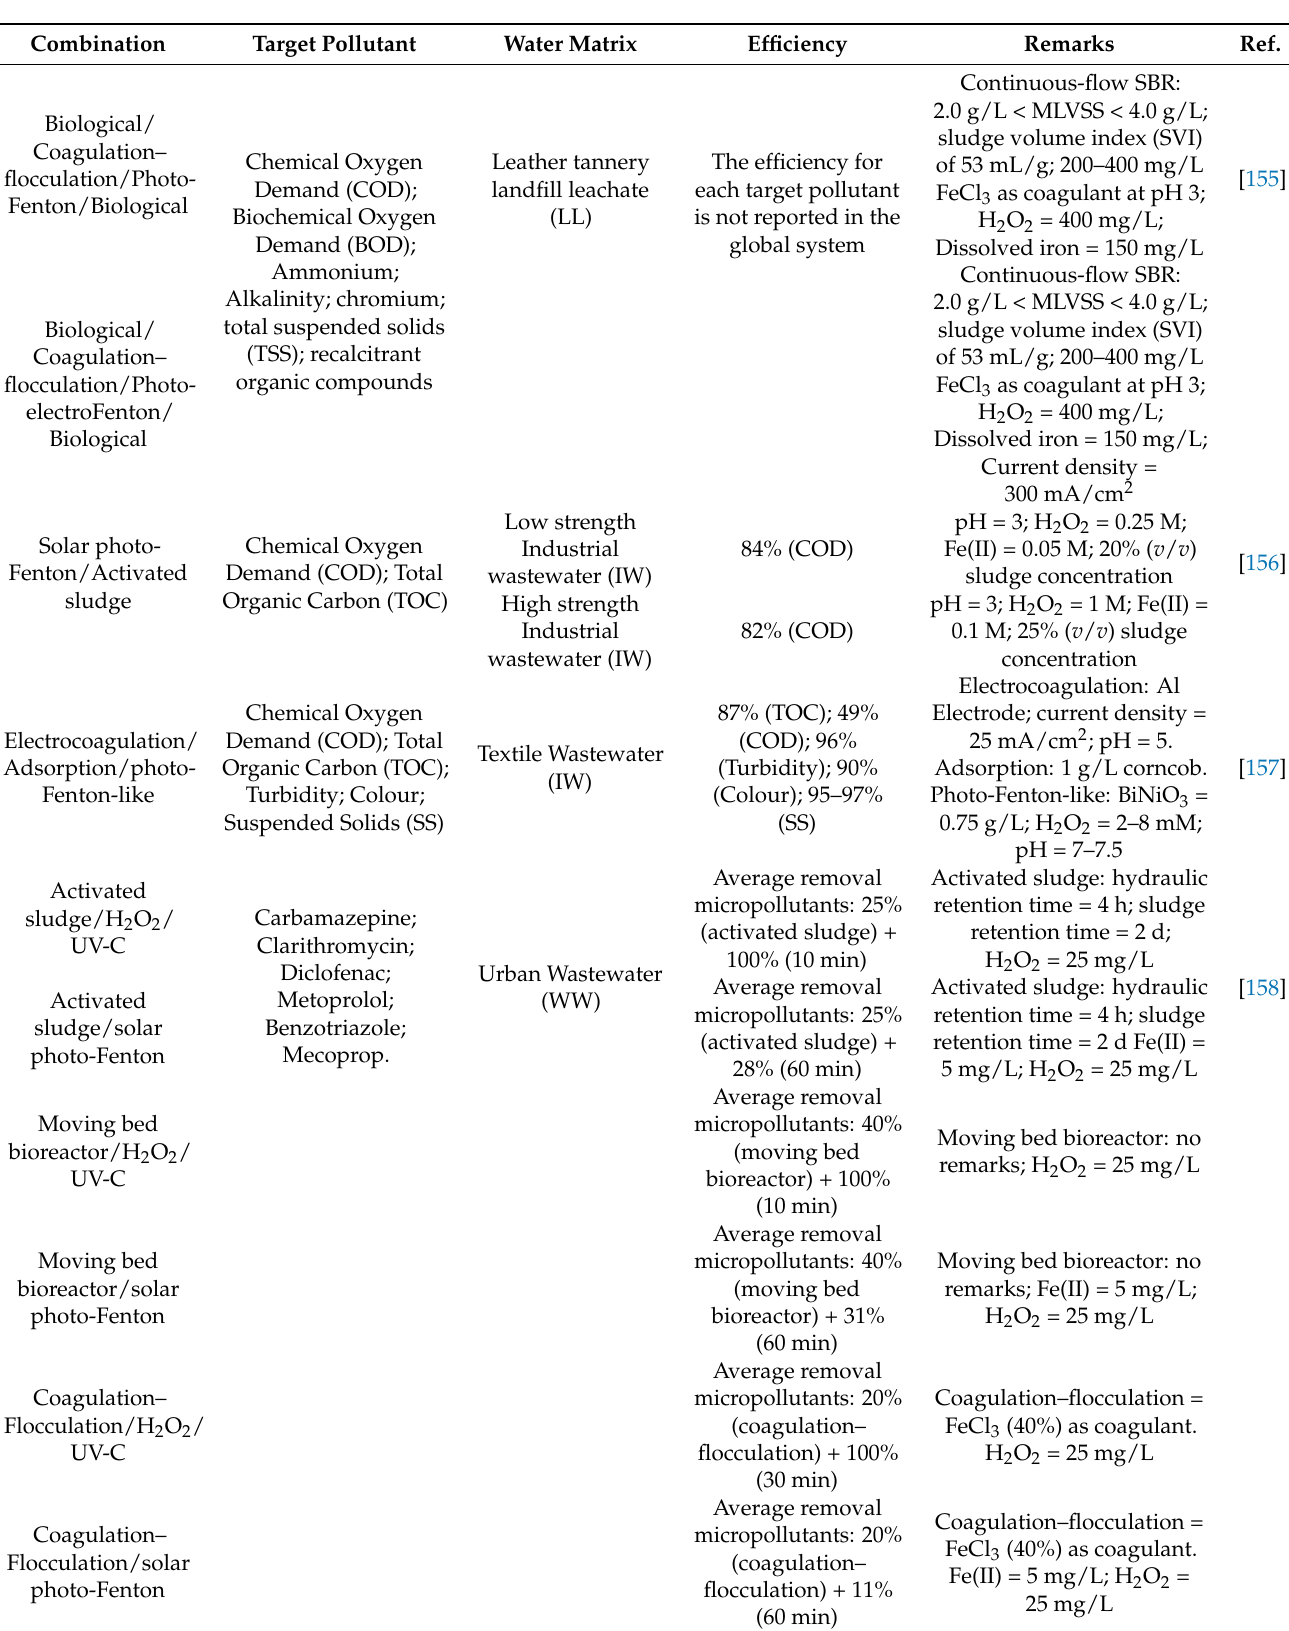
Table 13. Sequential or two-step combination processes (one photo-assisted AOP + other